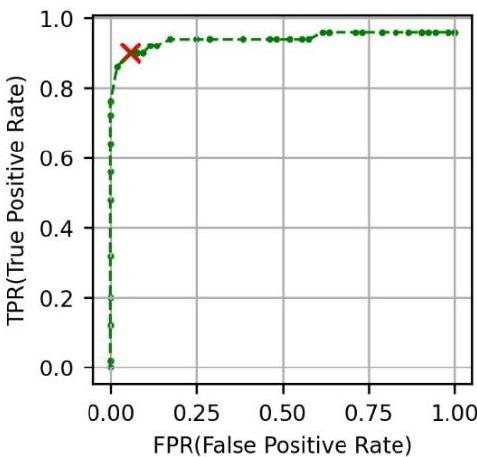
set; ( b ) minimum distance between a noise photo and reference set.